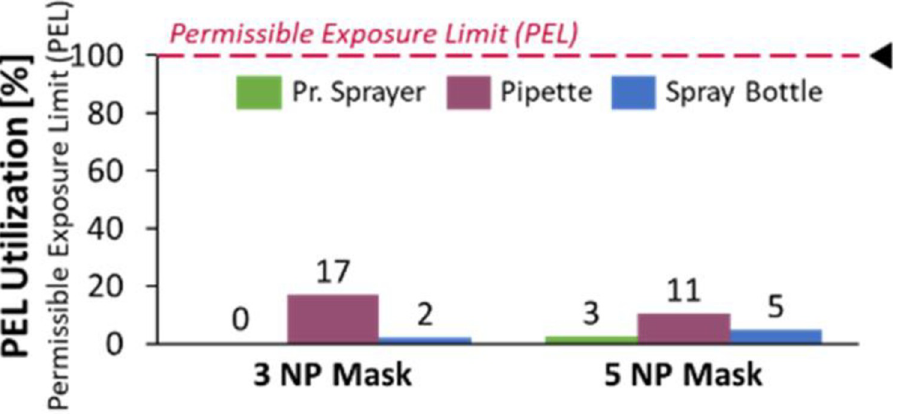
Fig 7. Pressurized sprayer yielded best deposition with lowest PEL